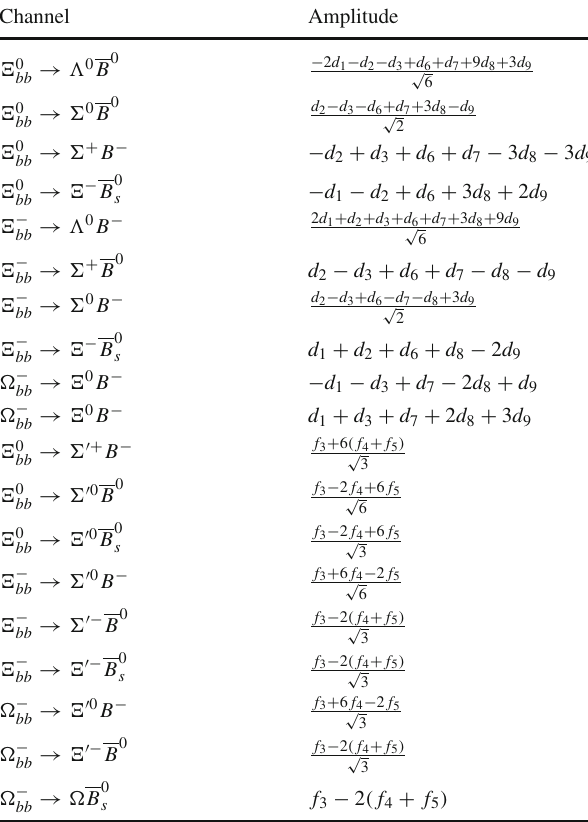
Table 19 Doubly bottom baryons decays into a bottom meson and a light baryon induced by the charmless b → d transition Channel Amplitude (cid:2) 0 → (cid:3) 0 B 0 s bb